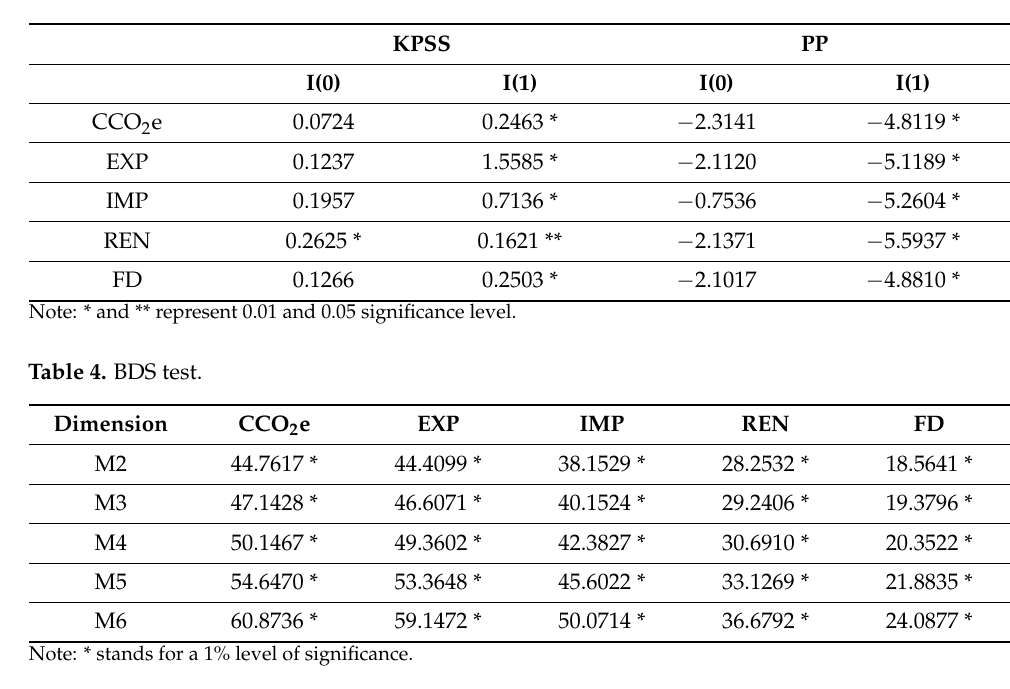
Table 3. Unit roots outcome.